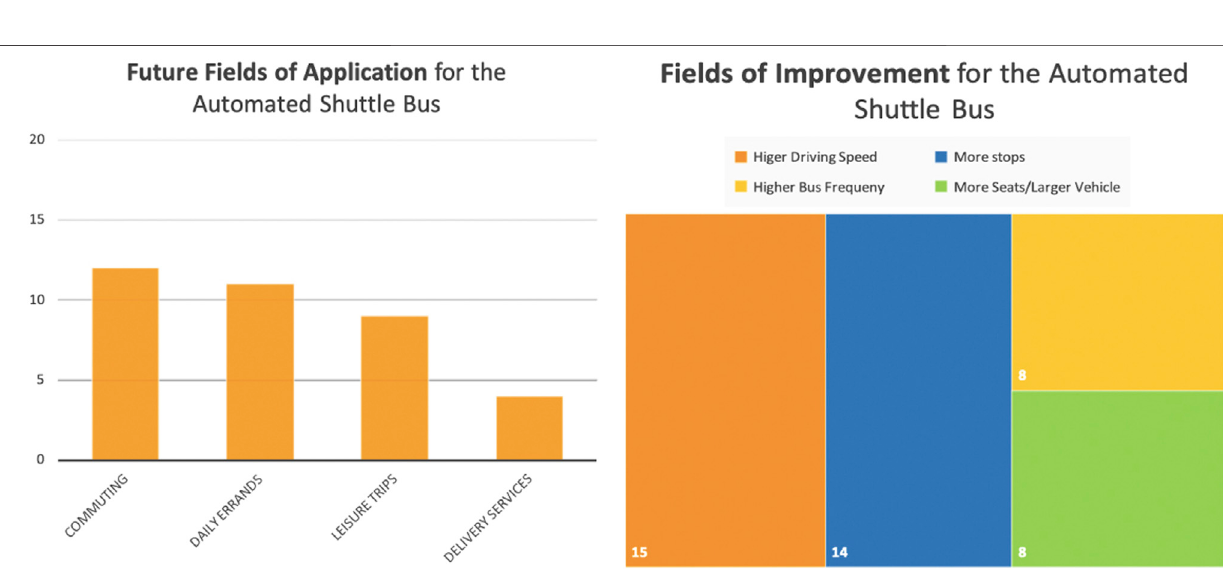
Frontiers in Human Dynamics |